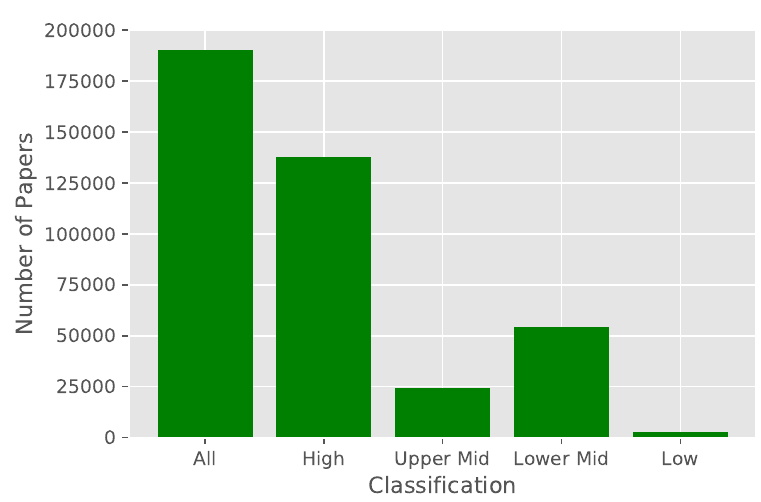
Figure 1. This chart shows the number of papers published in Multidisciplinary Digital Publishing Institute (MDPI) journals from 1996 through 2018 with at least one author from a country in a given income classification. Note that the sum of each income classification exceeds the total number of papers; these results are a consequence of international collaborations that transcend income